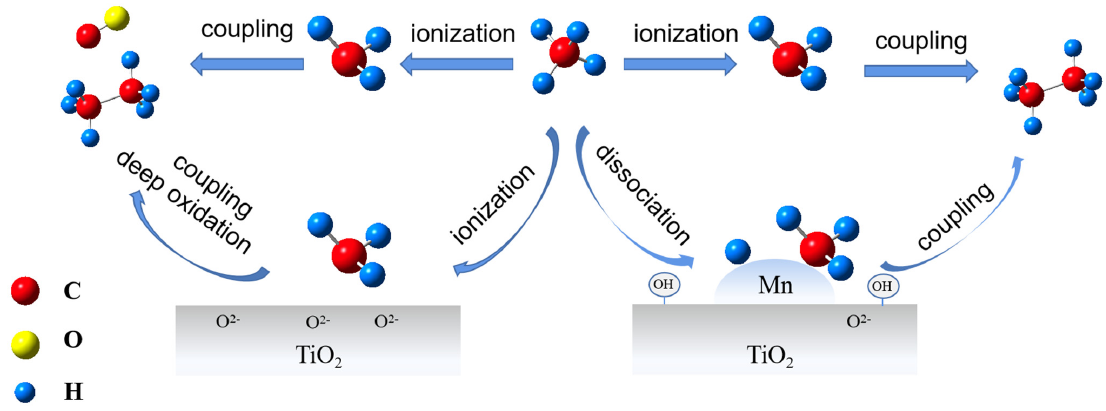
Figure 14. Possible reaction mechanism for CL-OCM on the MnTi catalyst.